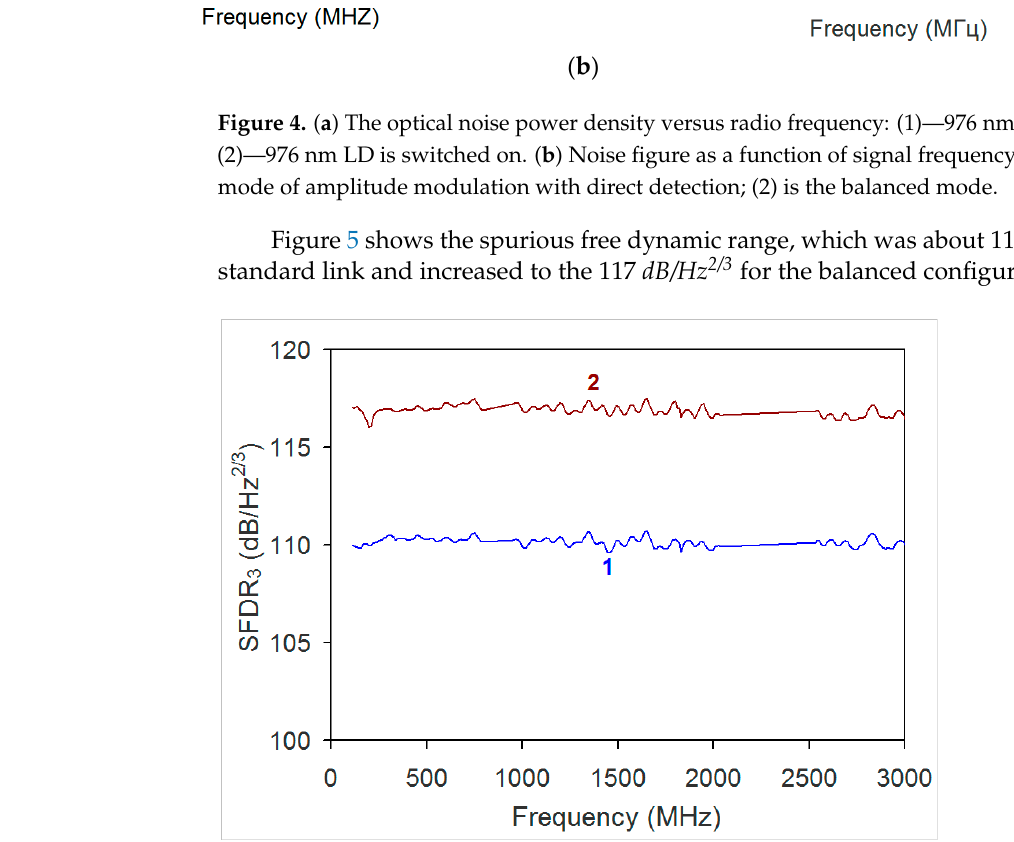
Figure 5. The spurious free dynamic range as a function of signal frequency; (1) is the standard mode of amplitude modulation with direct detection, and (2) is the balanced mode. of amplitude modulation with direct detection, and (2) is the balanced